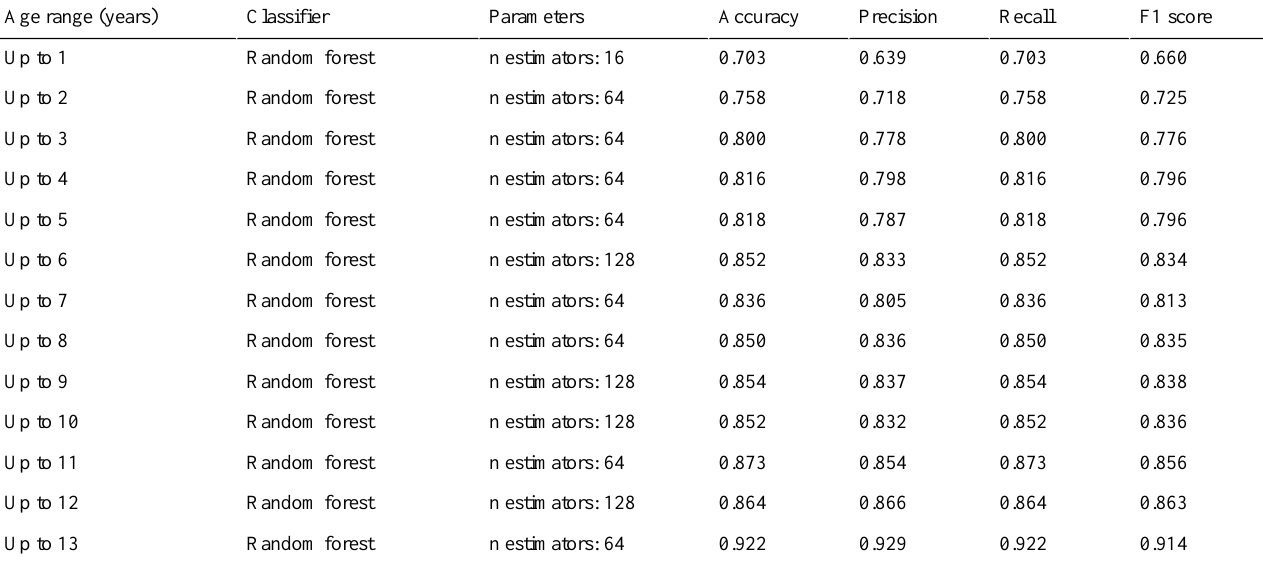
Table 4. Model learning results when using only disease diagnostic